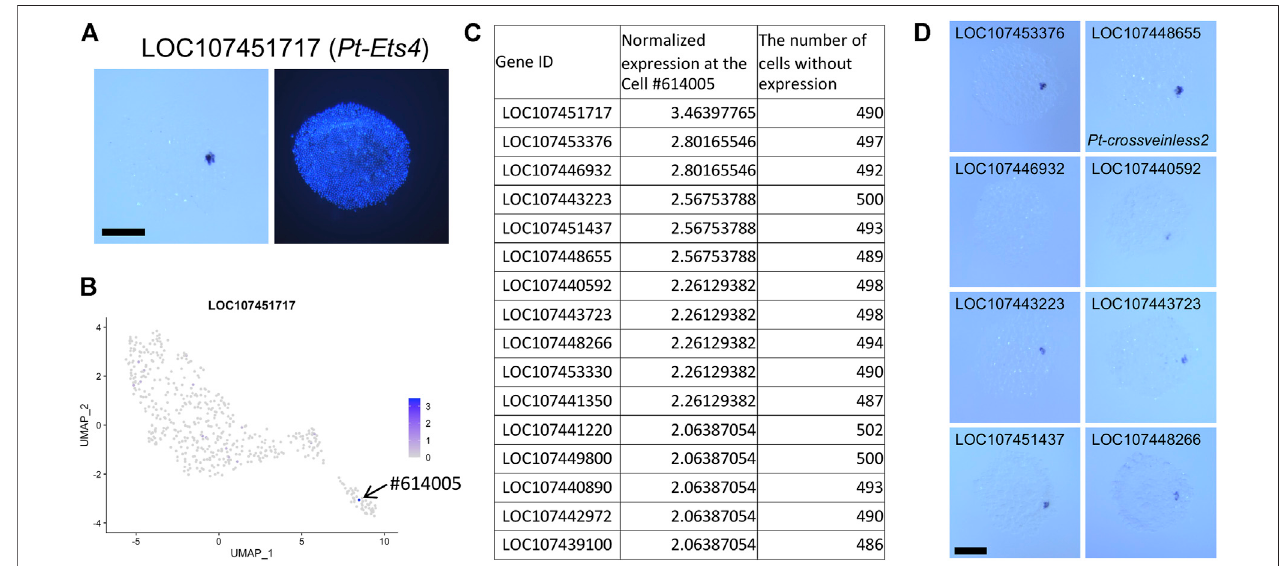
FIGURE5| Identi fi cationofCMcelltranscriptome. (A) ExpressionofLOC107451717( Pt-Ets4 )inagermdiscatlatestage5.ThesignalisdetectedattheCMcells. The right panel shows DAPI staining of the same embryo. (B) Expression of LOC107451717 visualized on the UMAP plot. Strong expression is detected speci fi cally at the cell #614005 in the endodermal cluster. (C) The list of genes that show speci fi c expression in the cell #614005. The normalized expression level in the cell #614005 and the number of cells (out of 505 cells) with no expression of the gene are shown. (D) Detection of transcripts of the top 9 genes (except LOC107451717) in the list. Signals are detected at the CM cells. Scale Bars = 200 μ m.